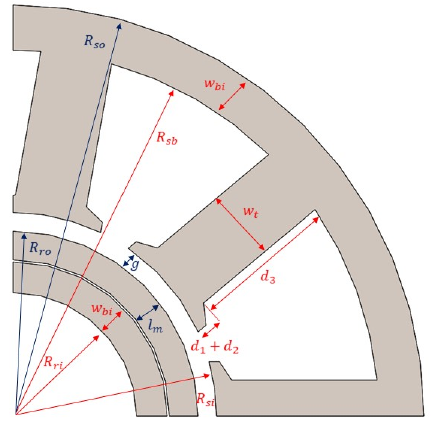
Figure 7. PMSM cross-section and main geometrical